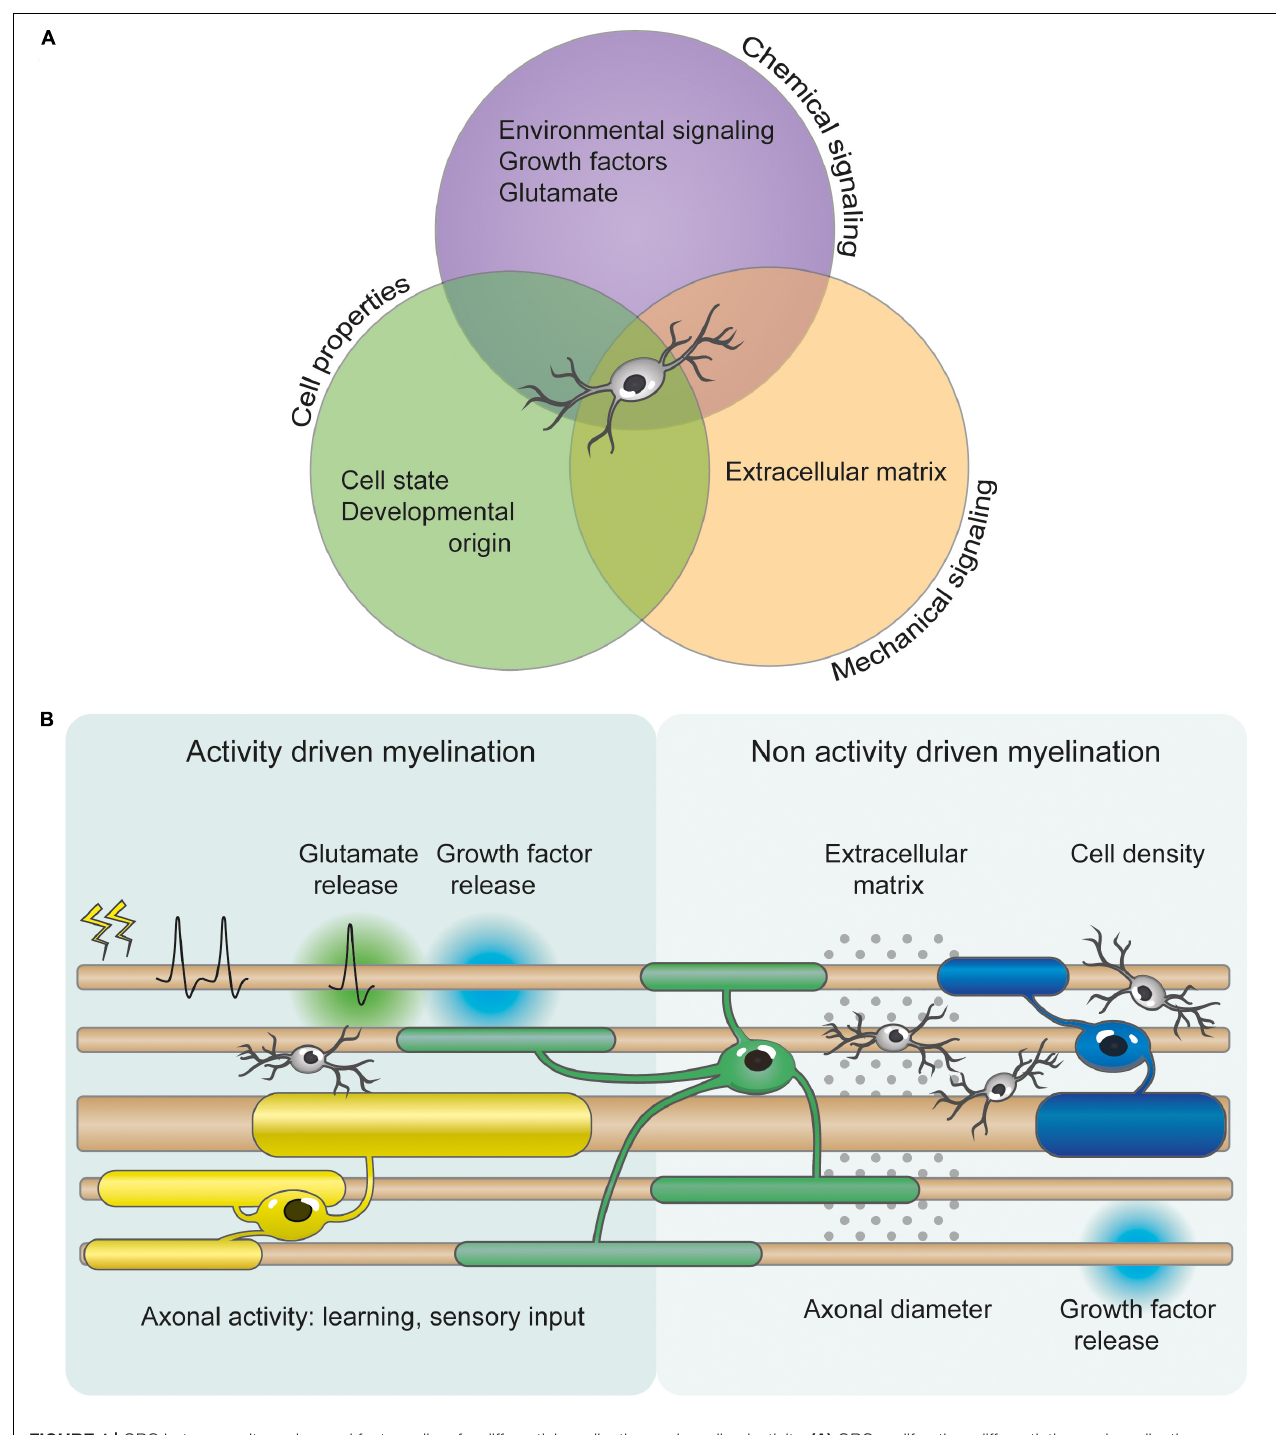
FIGURE 1 | OPC heterogeneity and axonal factors allow for differential myelination and myelin plasticity. (A) OPC proliferation, differentiation and myelination are orchestrated by numerous mechanical, cellular, and chemical signals. These include axonal diameter, growth factors, extracellular signaling molecules, extracellular matrix composition, cellular intrinsic deposition, neurotransmitters (such as glutamate), and neuronal activity. However, the relative importance of and cooperation between these signaling pathways is currently unclear. (B) Several studies indicate that myelination can be modified by activity- and experience-driven mechanisms. Glutamate and growth factor release from electrically active neurons can regulate OPC proliferation, differentiation and myelination. Additionally, motor and possibly cognitive learning, and sensory experience also influence myelination changes. However, myelination can also occur independently of neuronal activity. Non activity driven myelination could be regulated by the physical and mechanical properties of the extracellular environment, such as cellular density and extracellular matrix. OPCs are depicted in light gray. OLs are represented in different colors to illustrate the differential myelination.